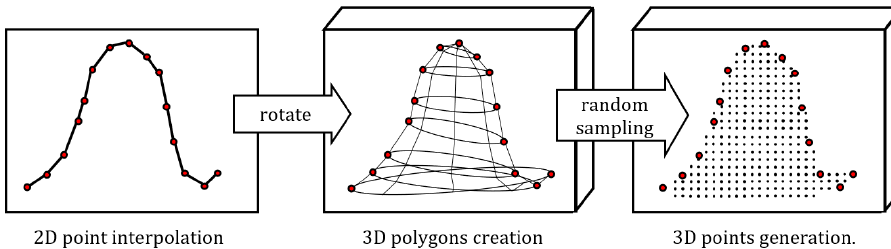
Figure 6. The flow chart of the proposed method.